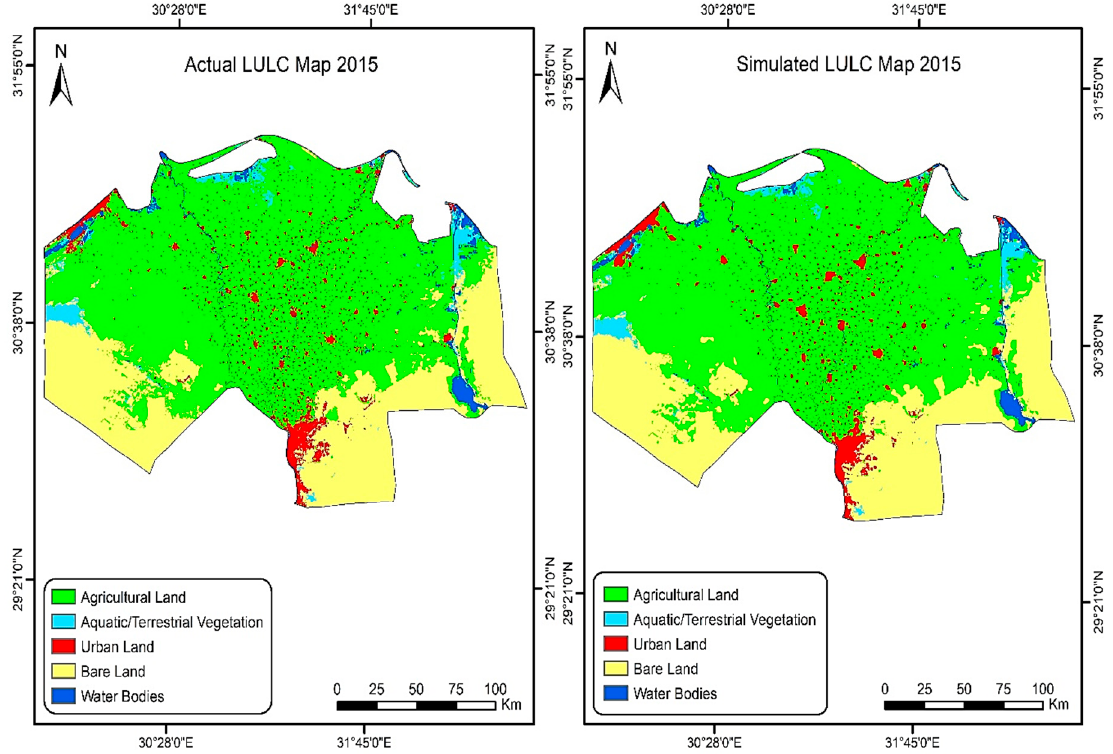
Figure 7. Actual (to the left) and simulated (to the right) LULC maps for 2015.